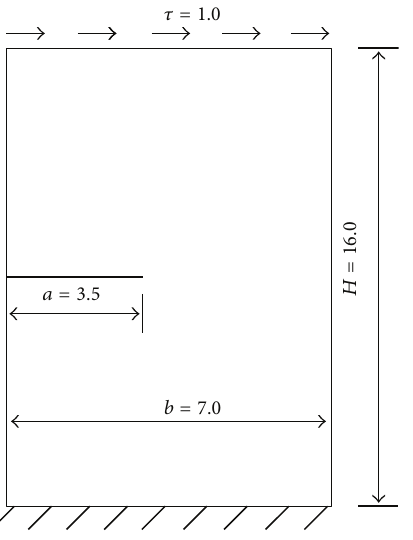
Figure 18: The convergence in the energy norm versus ℎ (mesh size) for a sheet with an edge crack under shear.